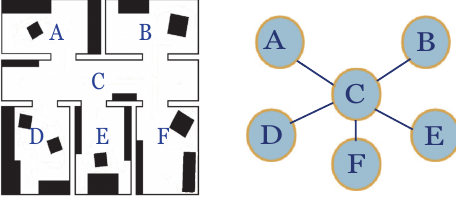
Figure 9: An place graph representing structural entities of an indoor